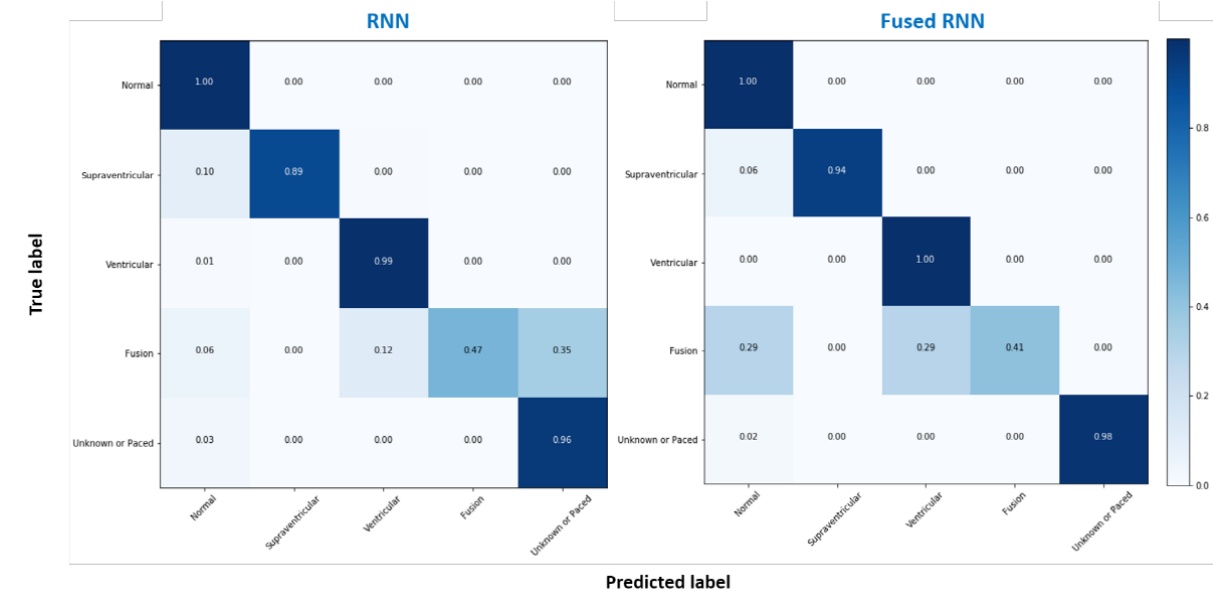
Figure 5. Normalized confusion matrix of the recurrent neural network (RNN) and fused RNN models.